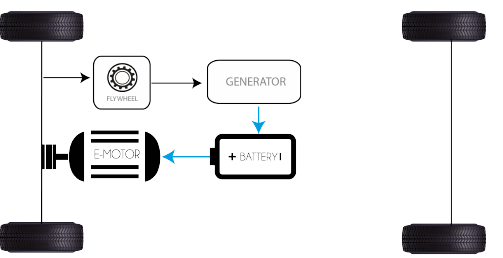
Figure 8. A diagram of the configuration of FES-ER.